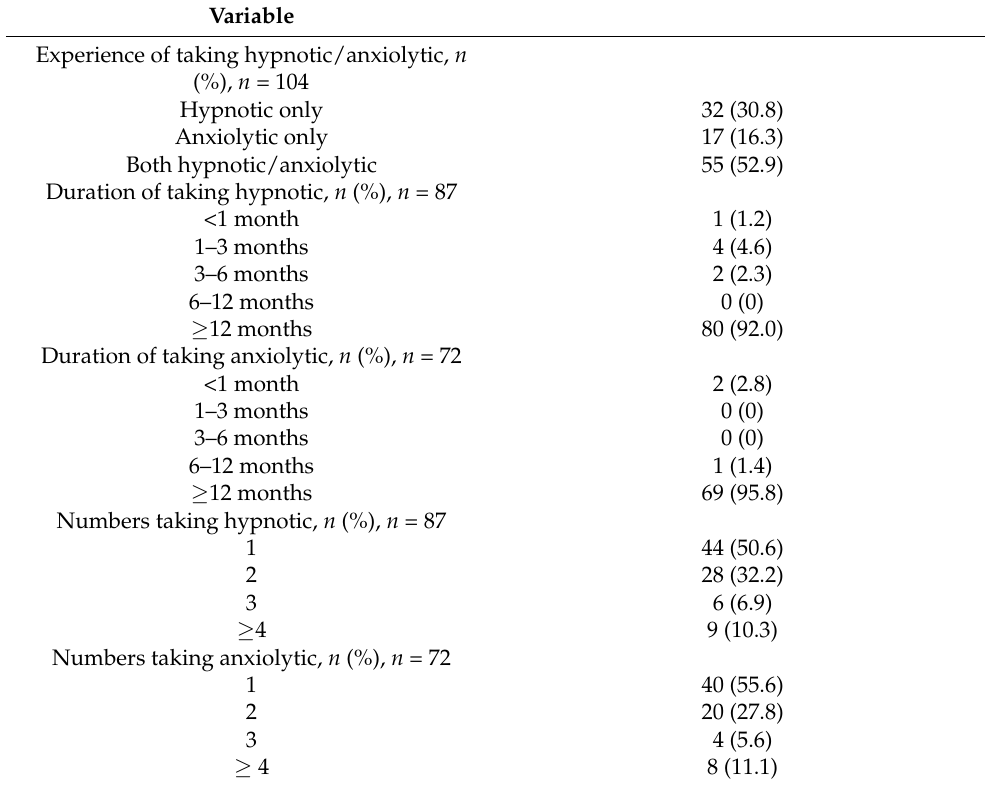
Table 2. Response of outpatients pertaining to the current situation of hypnotic/anxiolytic use.